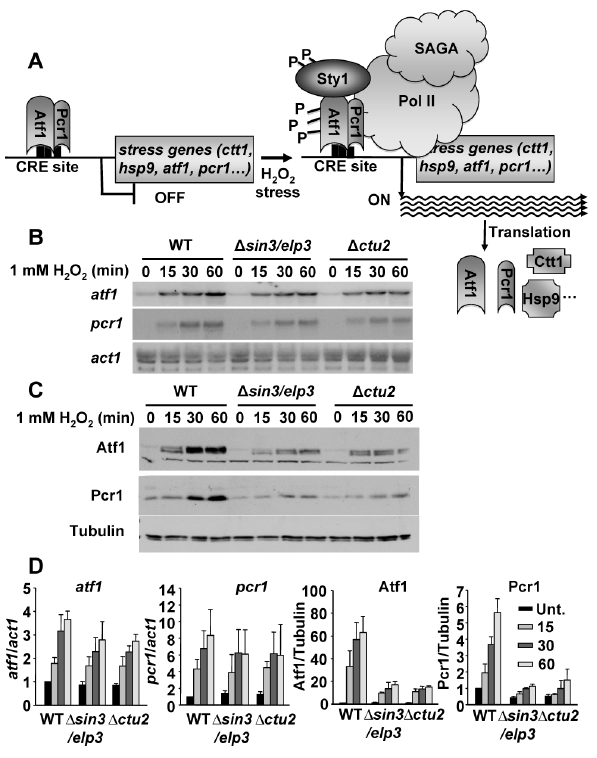
Figure 4. Protein levels of the stress transcription factors Atf1 and Pcr1 depend on the U 34 modifying activities Sin3/Elp3 and Ctu2. (A) Scheme illustrating the activation of the stress gene expression program by Atf1 and Pcr1 (see text for details). (B and C) Absence of Sin3/Elp3 or Ctu2 barely affects transcription of the atf1 and pcr1 genes but largely affects Atf1 and Pcr1 protein levels. Rich media cultures of strains 972 (WT), IV16 ( D sin3/elp3 ) and IV86 ( D ctu2 ) treated with 1 mM H 2 O 2 at the indicated time points were analyzed to determine transcription levels of atf1 and pcr1 genes by Northern blot (B), or Atf1 and Pcr1 protein levels by Western blot using polyclonal antibodies (C). act1 mRNA or tubulin were used as loading controls for B and C, respectively. (D) Quantification of the relative mRNA and protein levels for atf1 , pcr1 , Atf1 and Pcr1 in wild-type and mutant strains. The Northern or Western blot panels of experiments as in B and C, respectively, were quantified and represented here relative to untreated wild-type levels (with an assigned value of 1). The atf1 and pcr1 mRNA levels normalized to act1 are shown in the left two panels, w hereas the Atf1 and Pcr1 protein levels normalized to tubulin are shown in the two right panels. Error bars (SEM) were calculated from biological duplicates.